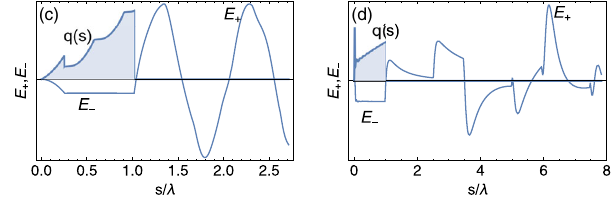
FIG. 4. Schematics of the dielectric lined waveguide.